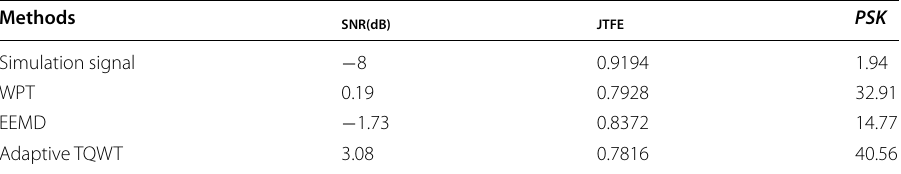
Table 1 Comparison of SNR and JTFE of output signals